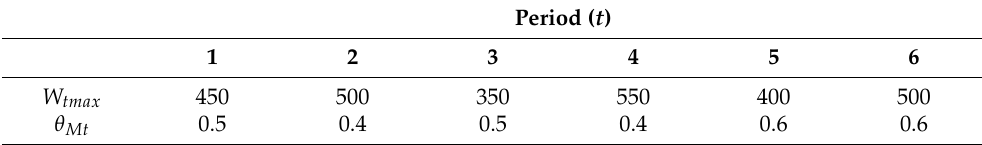
Table 3. Maximum Work Force and Fraction of Machine Capacity.